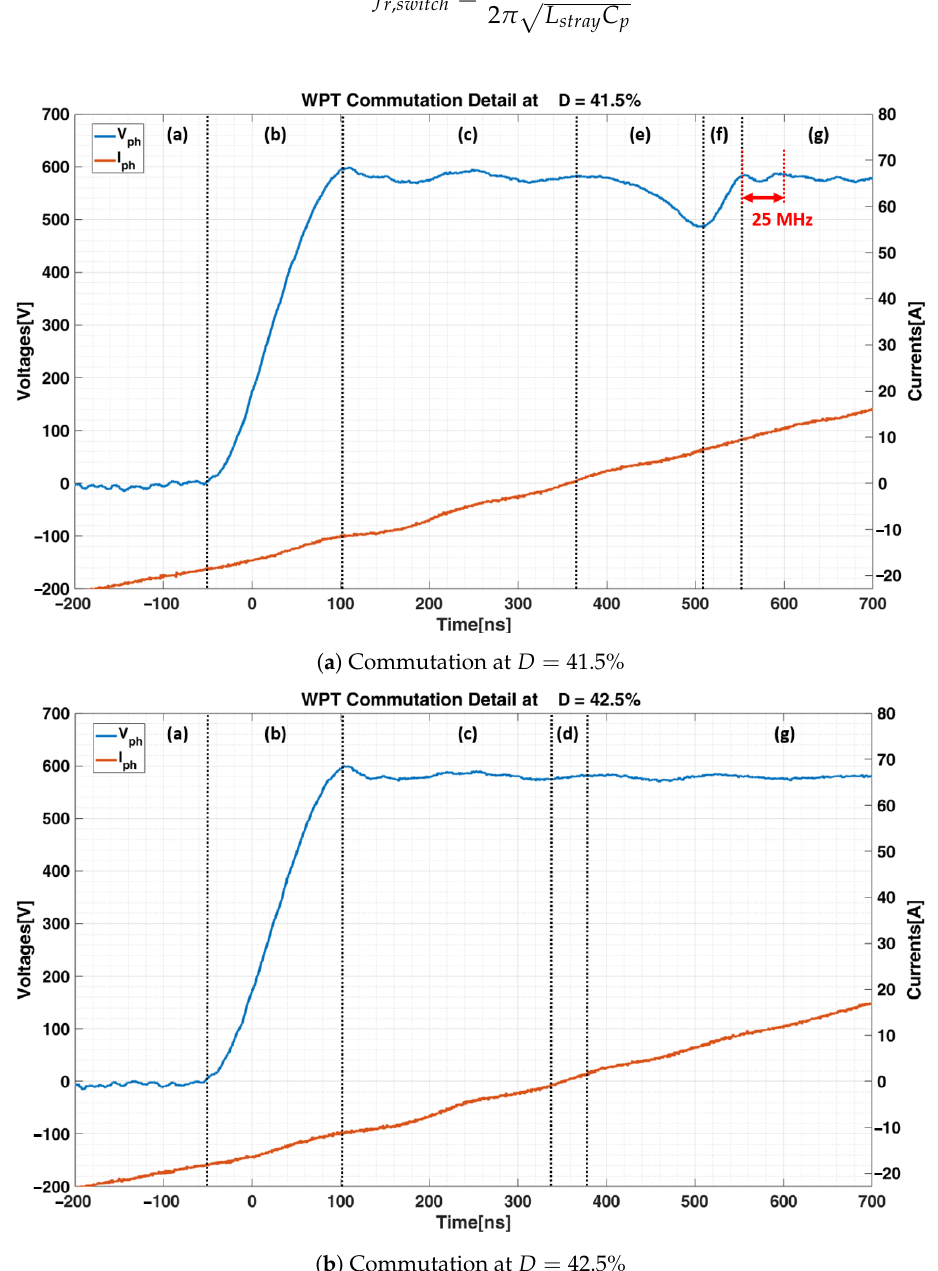
Figure 14. ( a ) Voltage and current waveforms at the limits of hard commutation. ( b ) Voltage and current waveforms reaching the limit of